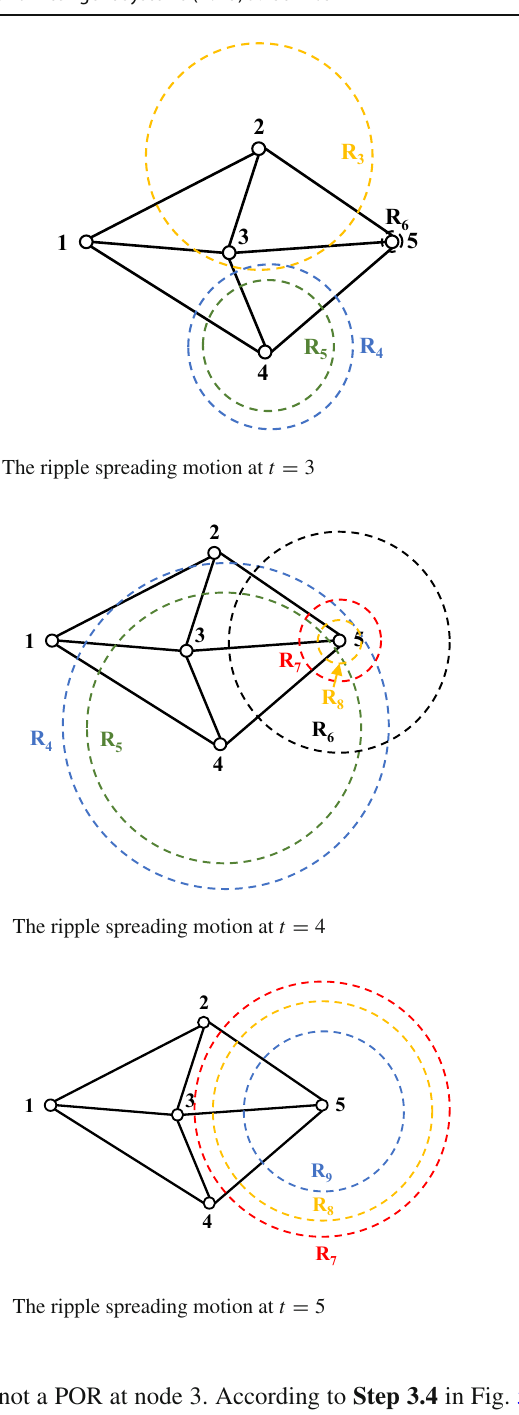
R 2 is not a POR at node 3. According to Step 3.4 in Fig. 5, it does not trigger any ripple.